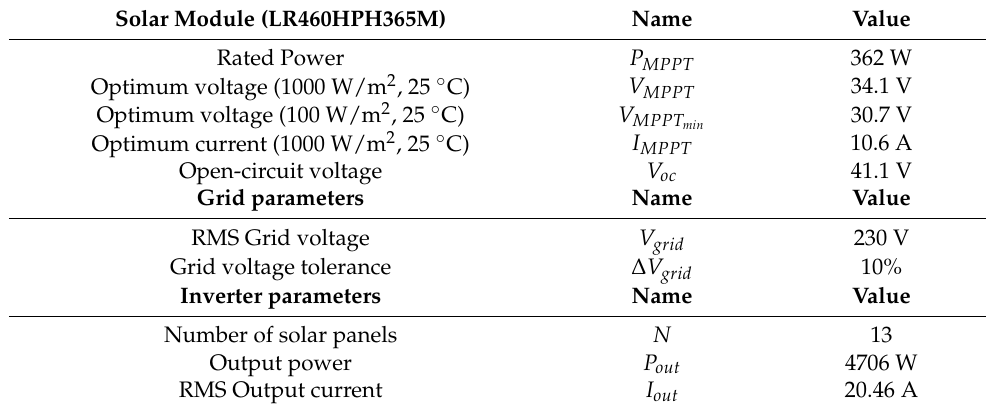
Table 2. Solar module, grid, and inverter